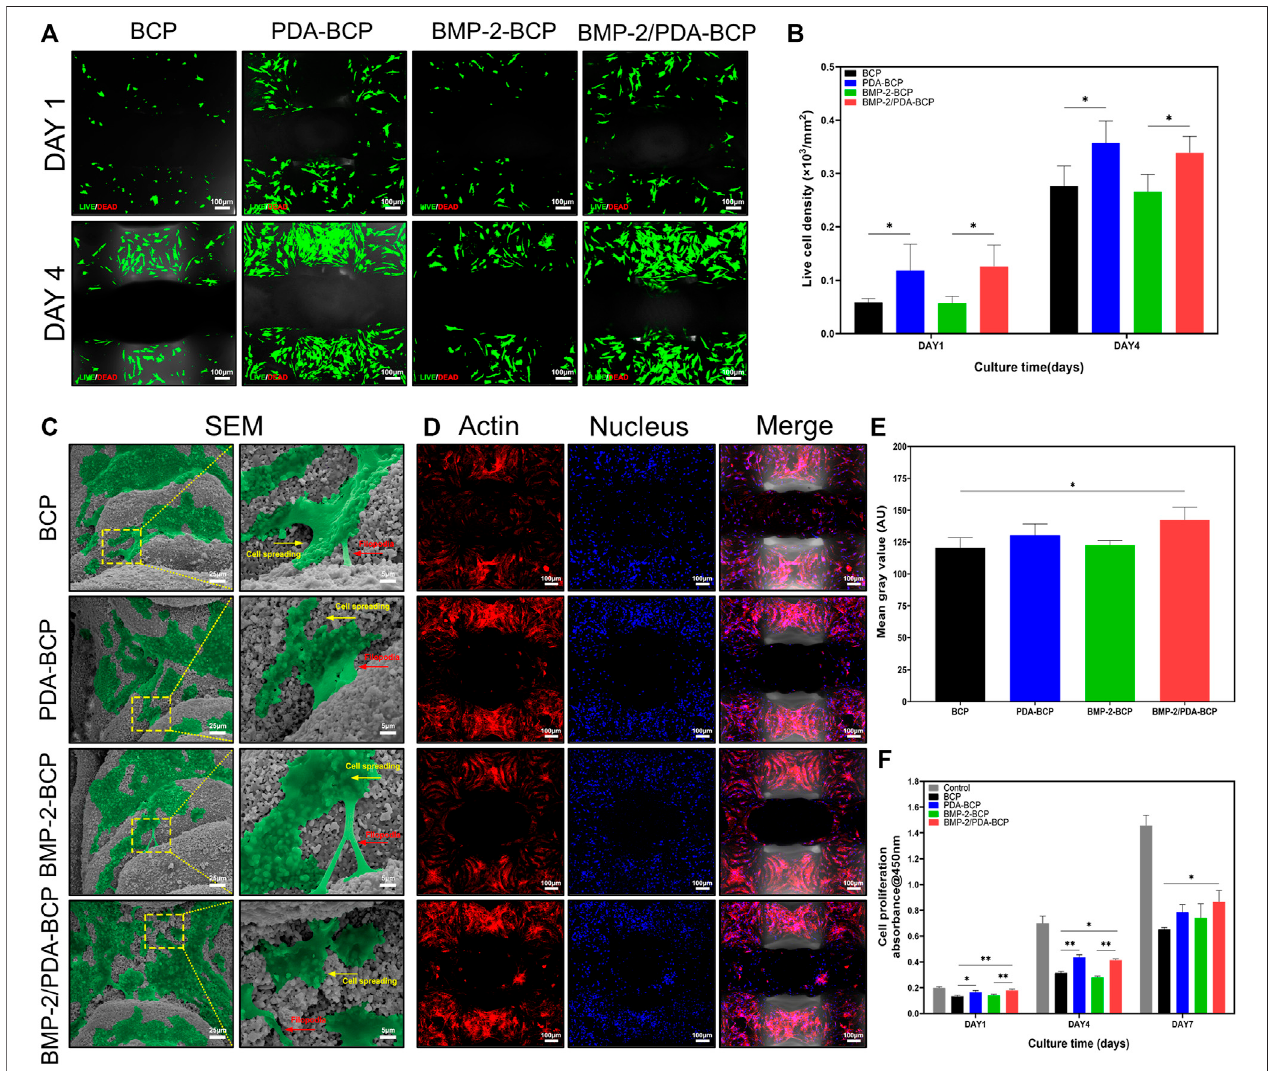
FIGURE4| Cellularcompatibility,adhesion,andproliferationofBMSCsonscaffolds. (A) Fluorescenceimagesoflive(green)/dead(red)cellstainingand (B) livecell density of BMSCs grown on BCP, PDA-BCP, BMP-2-BCP, and BMP-2/PDA-BCP scaffolds after 1 and 4 d ofculture. * p < 0.05. Scale bars = 100 μ m. (C) Morphology of BMSCs adhered after 24 h on the surface of scaffolds. Scale bars = 25 μ m. The higher magni fi cation shows BMSCs with longer fi lopodial extension. Scale bars = 5 μ m. (D) Confocal microscopic images ofBMSCsattached tothe internal struts ofthe scaffolds stained withF-actin(phalloidin,red) and nuclei (4 ′ ,6-diamidino-2- phenylindole,blue)at7 daftercellseeding.Scalebars=100 μ m. (E) QuantitativeevaluationofF-actinstainingimages.* p < 0.05. (F) CCK-8assayforcellproliferationon various scaffolds for 1, 4, and 7 d culturation. The data are shown as the mean ± S.D. * p < 0.05, ** p < 0.01.